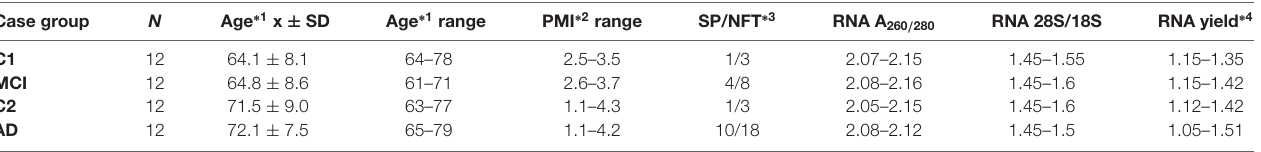
TABLE 1 | Summary of tissues used from each case group in this